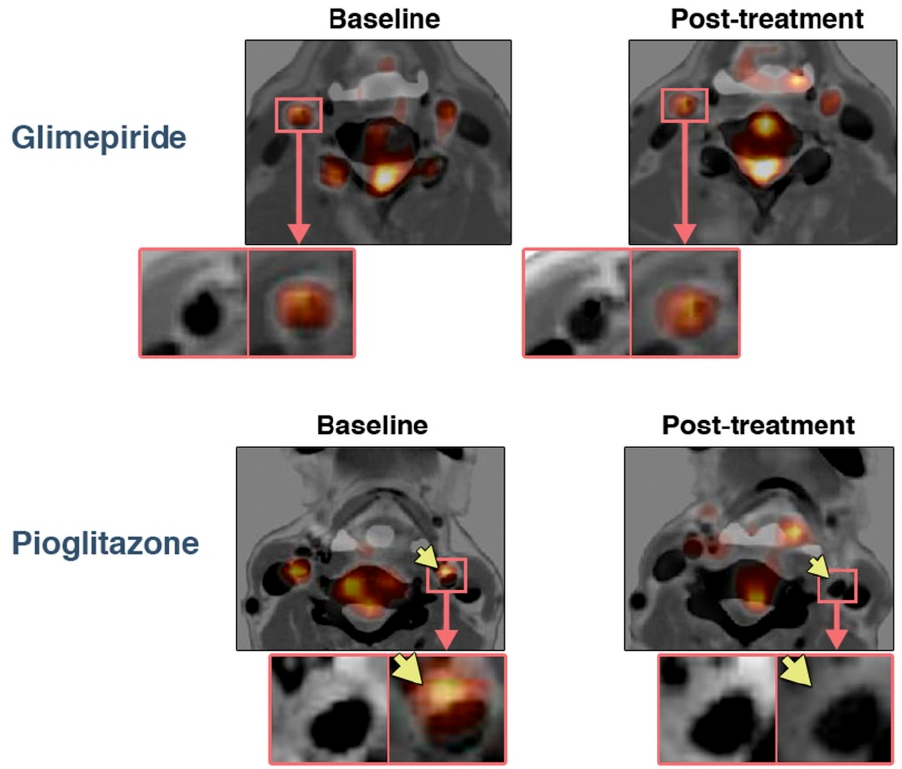
Figure 2. Treatment effects on FDG uptake in atherosclerotic plaques. Representative FDG PET/CT with contrast media images ( left ) at baseline and ( right ) after four months of treatment with ( bottom ) pioglitazone or ( top ) glimepiride. Note the reduction in FDG uptake in the atherosclerotic plaque with pioglitazone treatment (arrows). Reprinted with permission from Ref. [41]. © 2022, The American College of Cardiology Foundation.